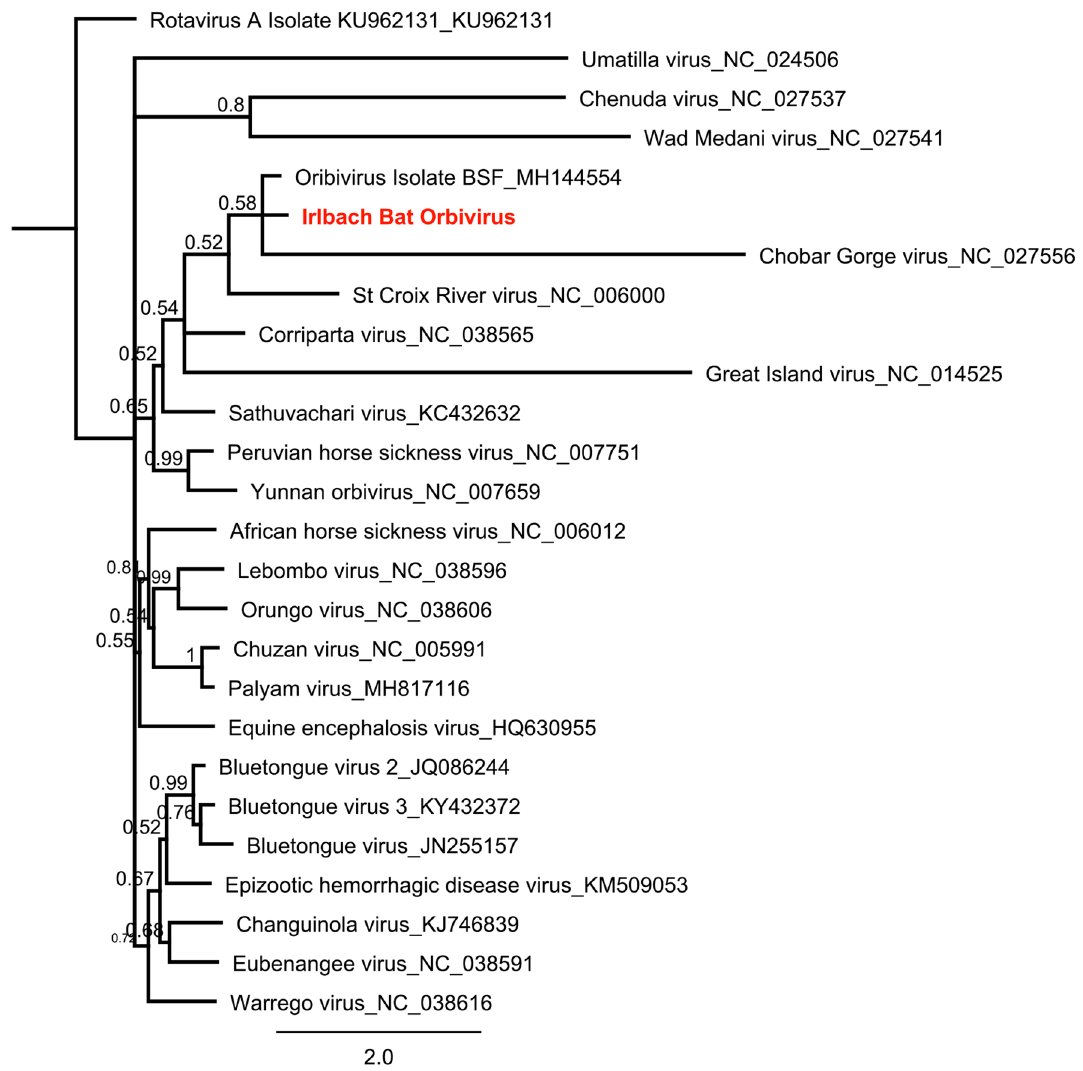
Figure 3. Phylogenetic reconstruction of Orbiviruses ML, 1 million, 780 nt of the VP4 protein. Reconstruction was performed via the Bayesian MCMC approach using MrBayes with the following settings (burn-in, 10%; frequency, 200; chain length, 1 million to 10 million, depending on when a standard derivation of below 0.025 was reached) 78 . Reconstructed trees were visualized using FigTree and posterior probabilities were depicted for each node (http:// tree. bio. ed. ac. uk/ softw are/ figtr